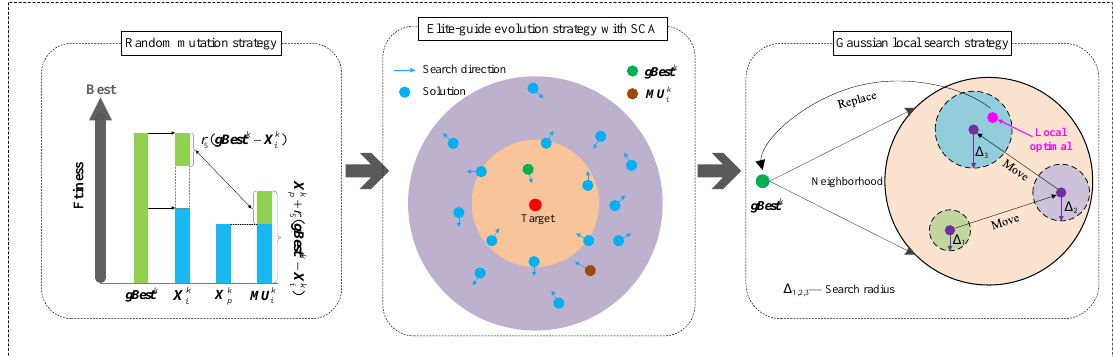
Figure 3. Sketch map of the HSCA algorithm. Table 1. Execution pseudocode of the Hybrid Sine Cosine Algorithm (HSCA) method.